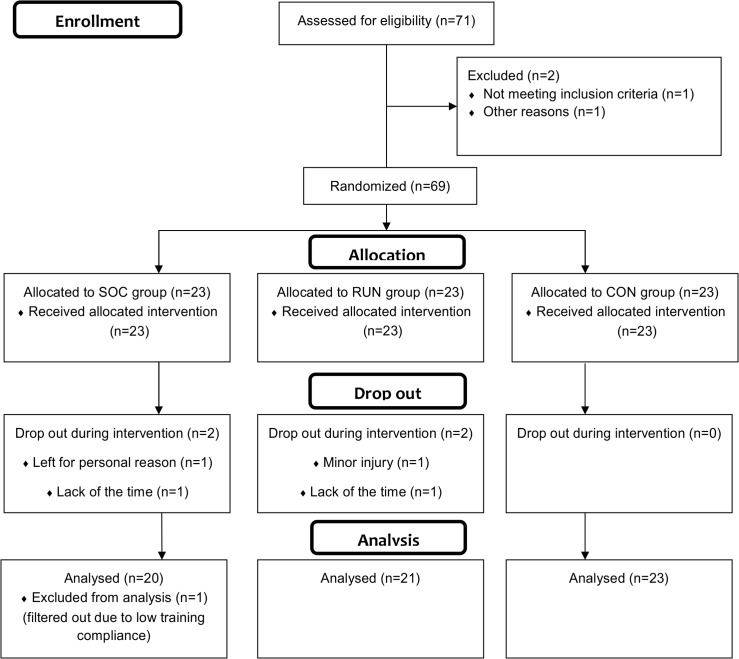
Flow chart diagram of participants’ enrolment, randomization and final analysis.